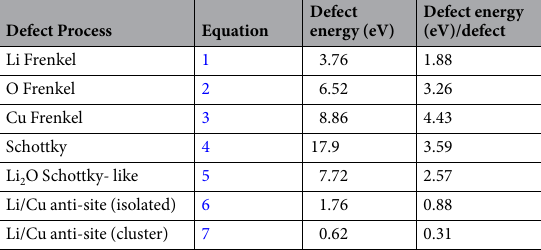
Table 1. Energetics of intrinsic defects in Li 2 CuO 2 .